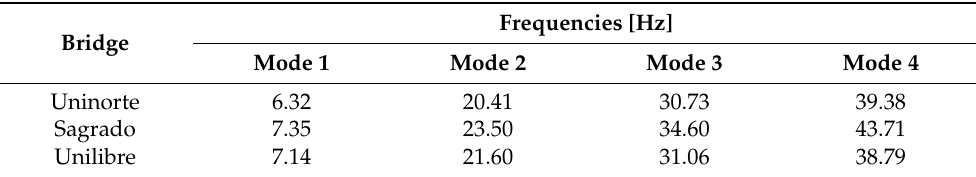
Figure 12. First four vertical modes of vibration obtained from the initial numerical model of the bridges. Table 4. Frequencies associated with the first four vertical vibration modes in [Hz] of the initial analytical model.